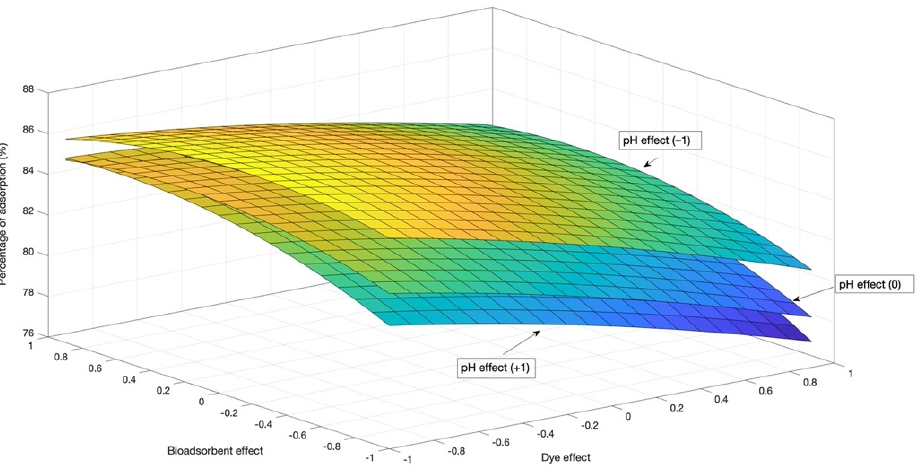
Figure 3. Estimated response area for the percentage of Congo red dye adsorption by the cocoa bean shell powder.